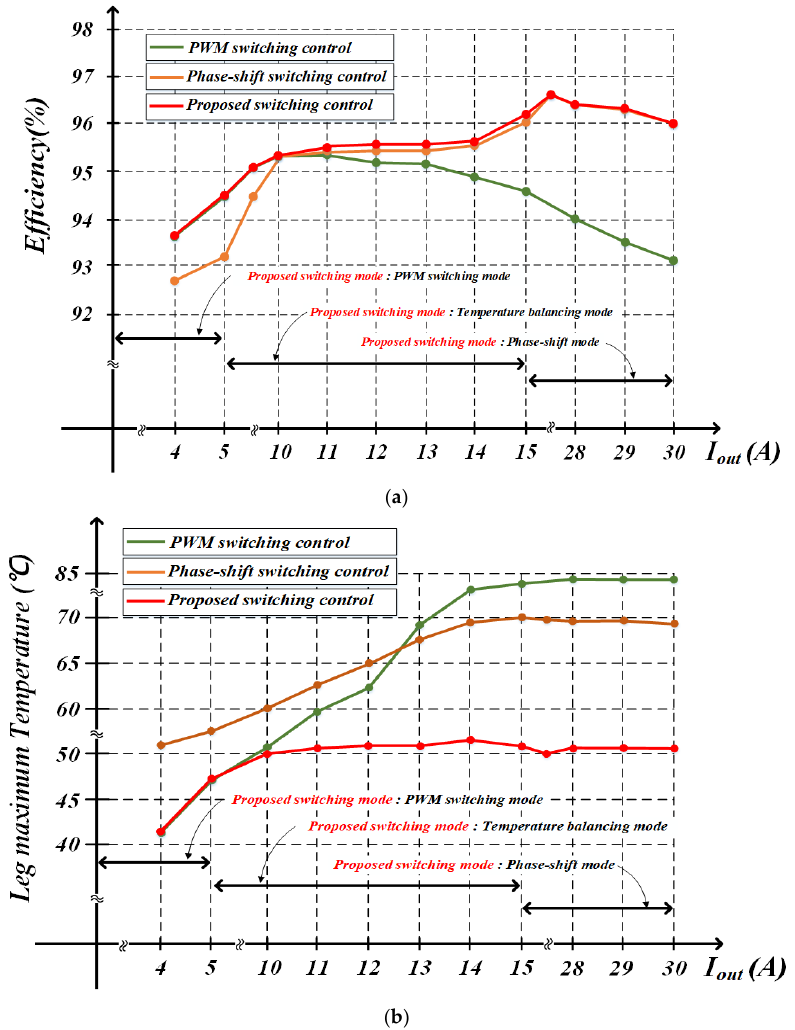
Figure 15. Efficiency and temperature measurements for switching techniques. ( a ) Converter Figure 15. E ffi ciency and temperature measurements for switching techniques. ( a ) Converter e ffi ciency efficiency for the output current. ( b ) Maximum leg temperature for the output current. for the output current. ( b ) Maximum leg temperature for the output